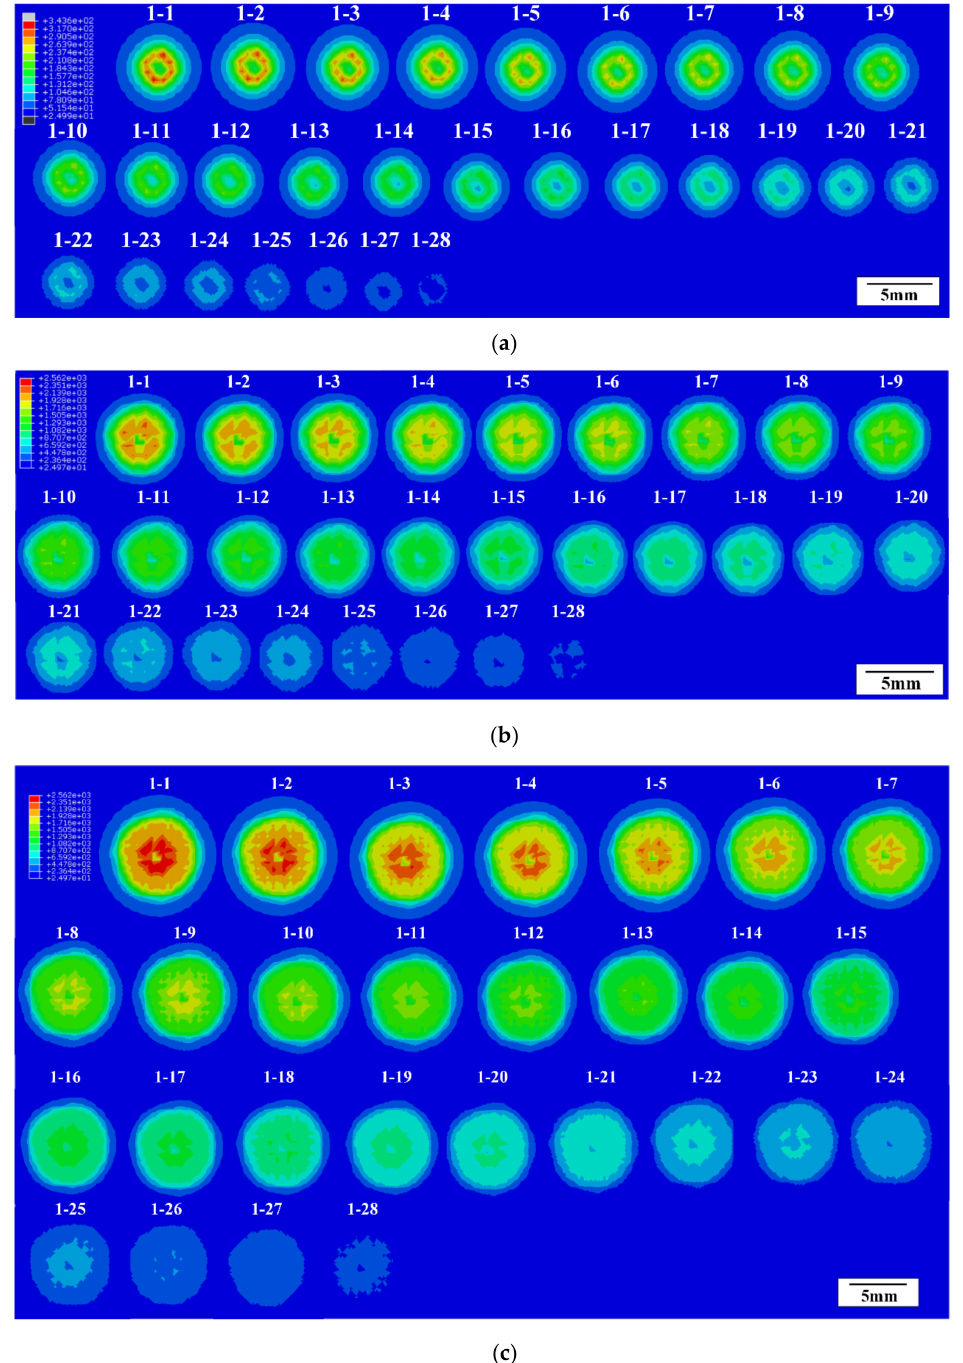
Figure 9. Tomography images’ summaries of di ff erent FEA models in Group B: ( a ) the B20s; ( b ) the B40s; ( c ) the